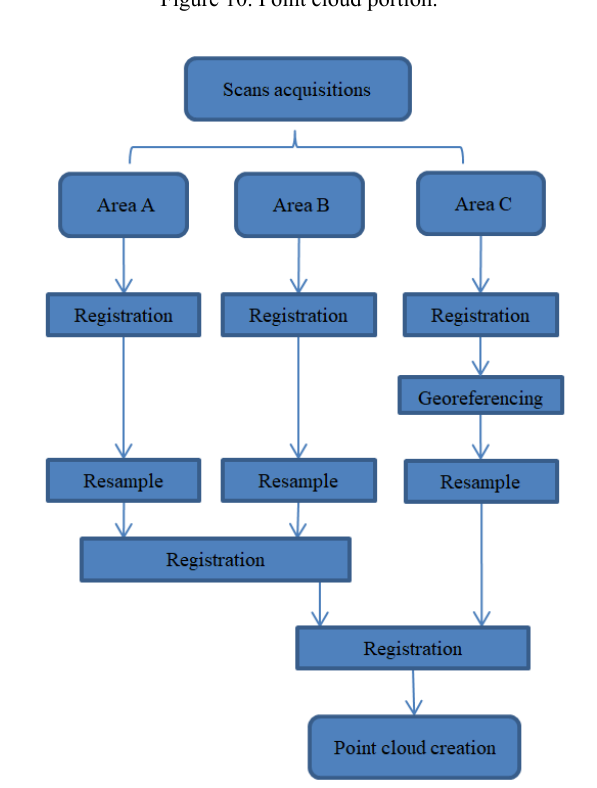
Figure 10. Point cloud